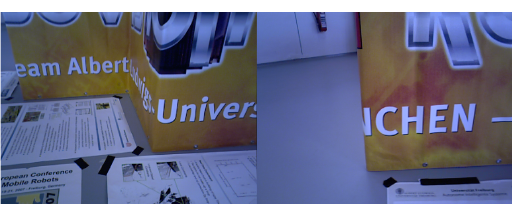
Figure 10. Sample images of fr3_str_tex_near sequence.